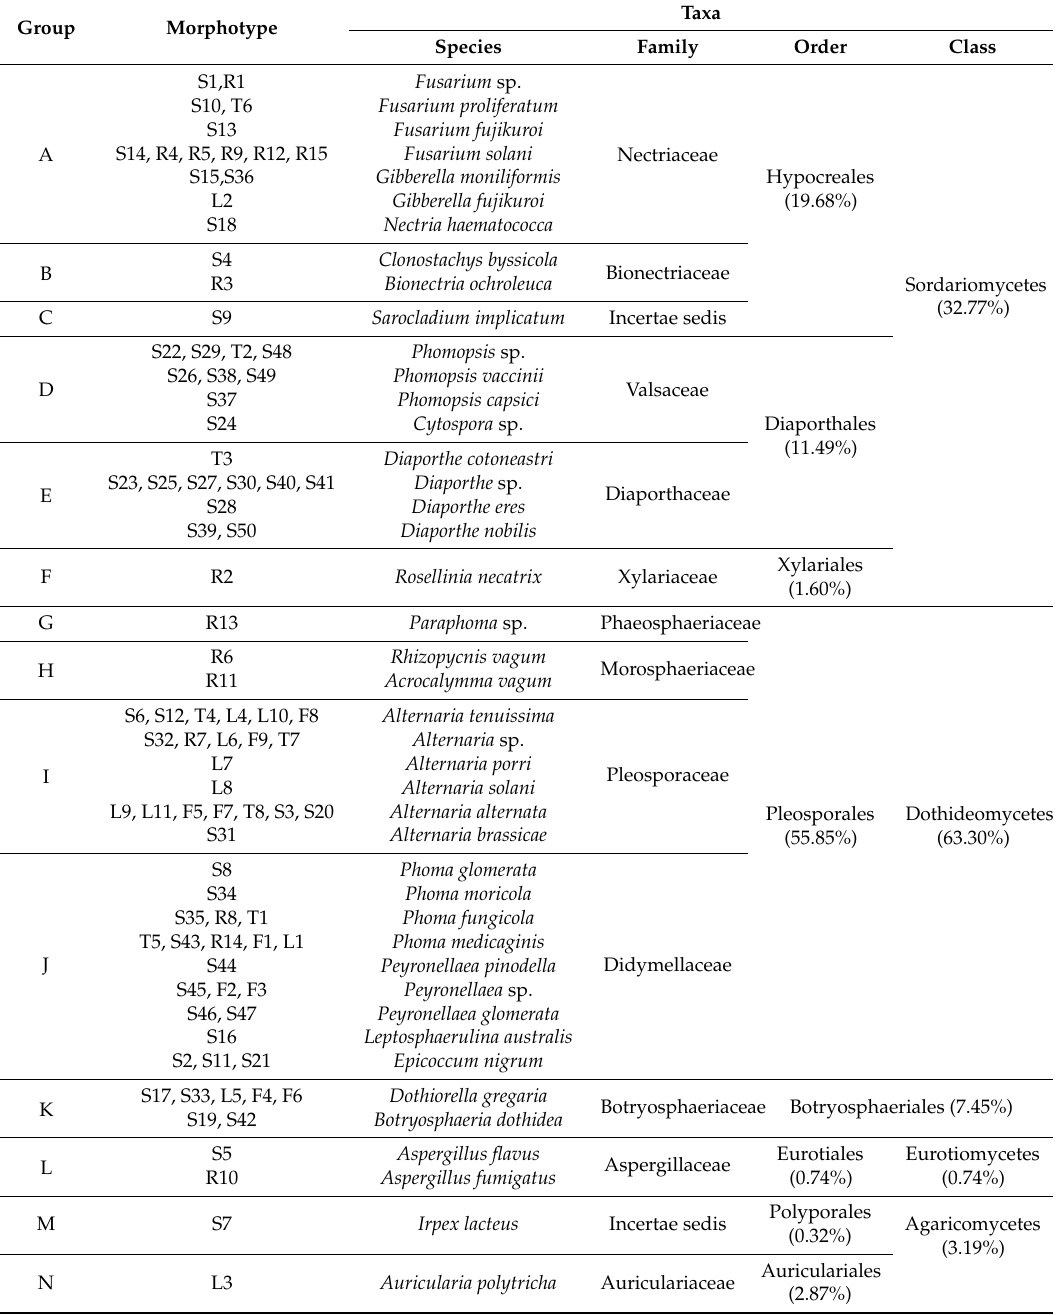
Table 2. Cluster analyses of all endophytic fungi isolates from Z. bungeanum